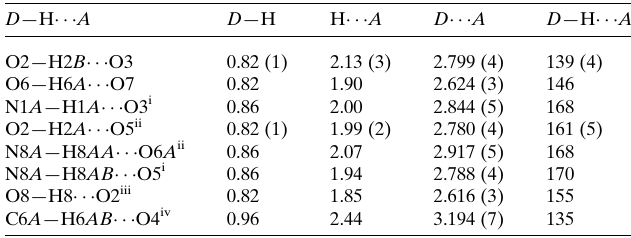
Table 1 Hydrogen-bond geometry (A˚ , (cid:4) ).